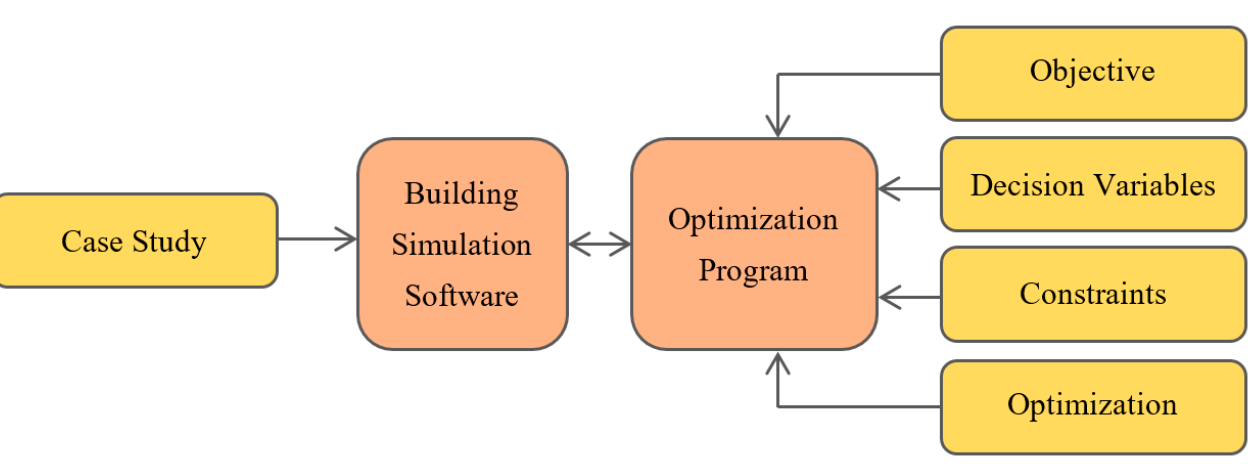
Figure 2. Share of different types of multi-objective optimization (MOO) in the core literature.